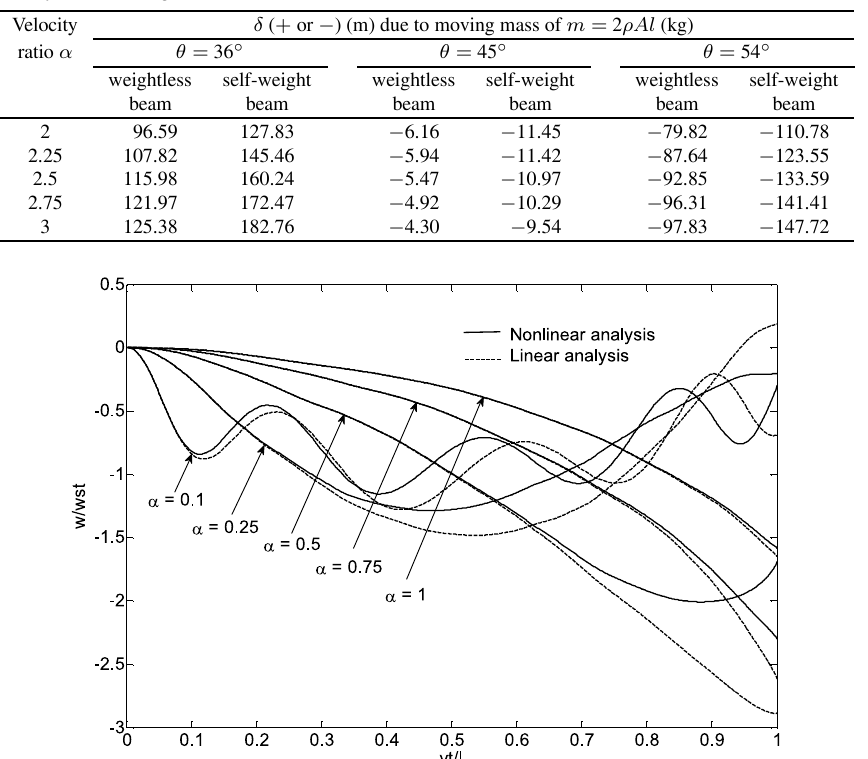
Table 2 δ variation in targeting of planar projectile onan inclined Timoshenko beam for various α using nonlinear analysis for moving mass model; ( v cr = 131.60 m/s)